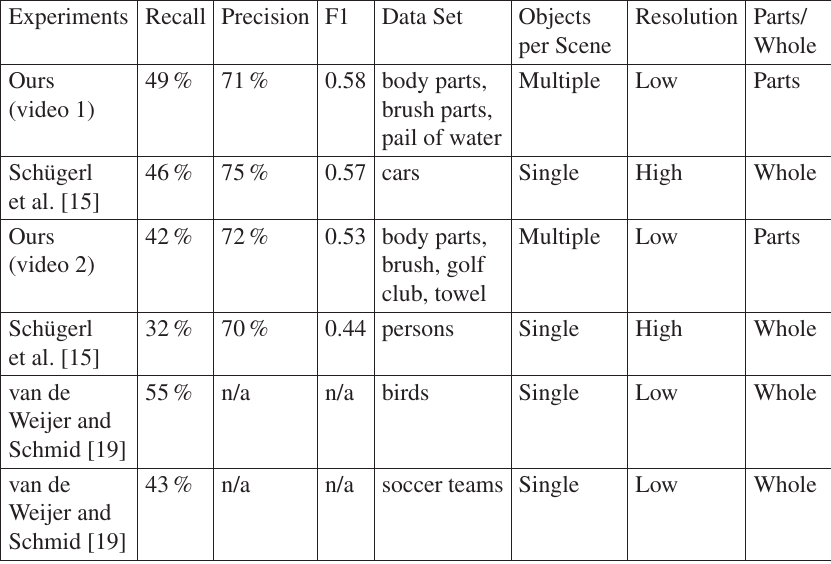
Table 6. Comparison of results with similar